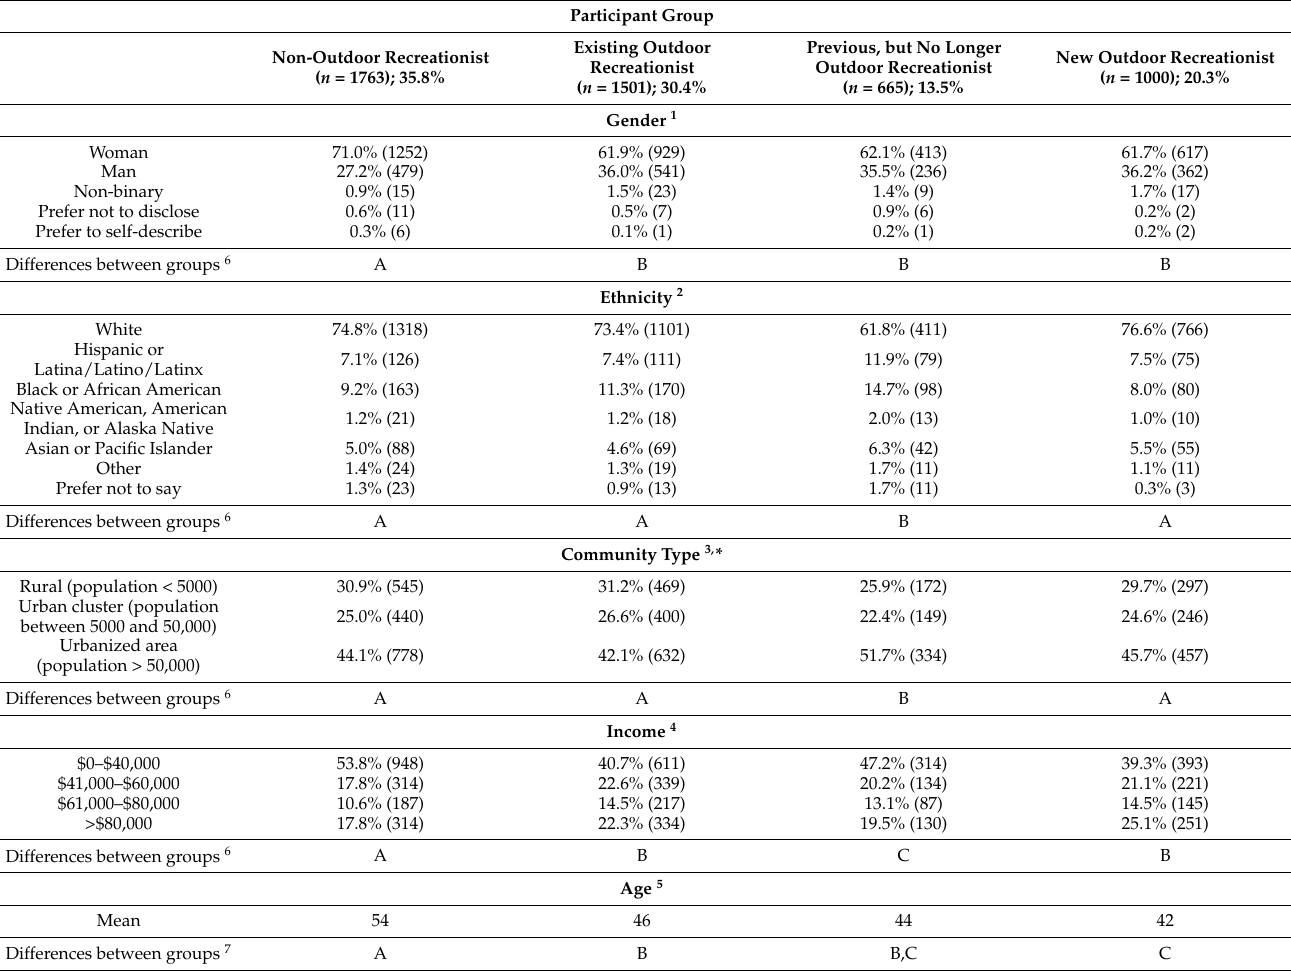
Table 3. Breakdown of non, existing, no longer, and new outdoor recreationists by